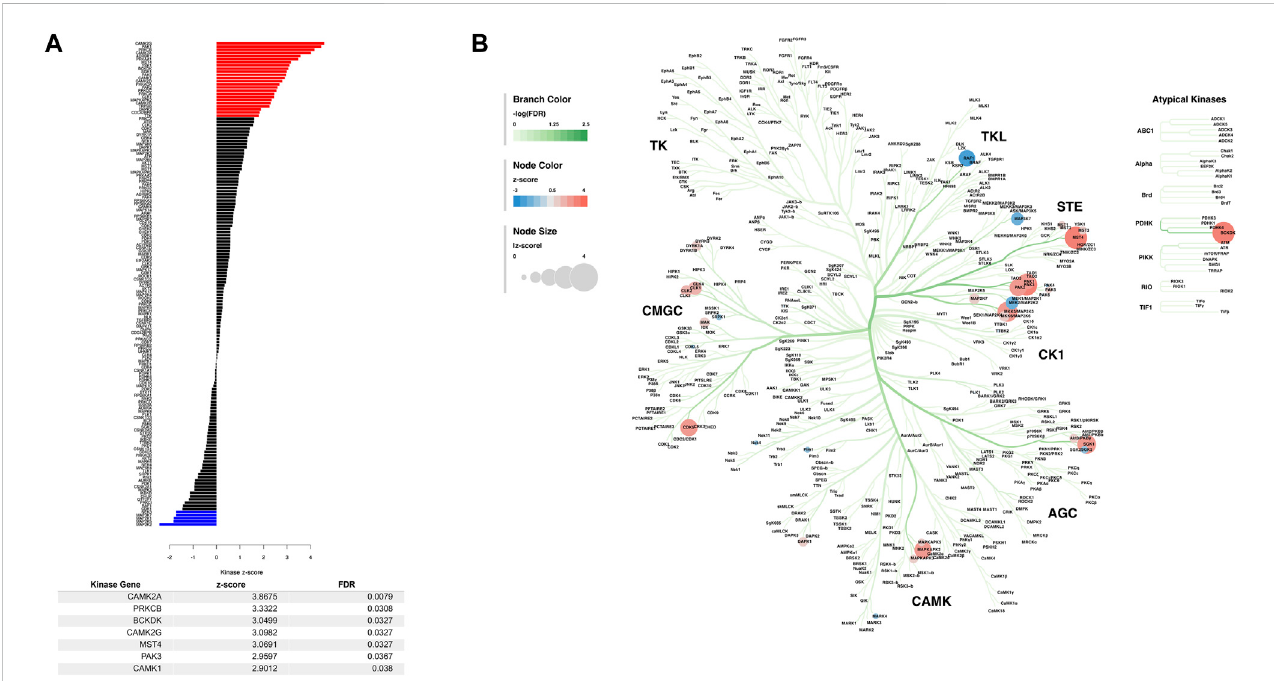
FIGURE 3 Dysregulated kinases and kinome mapping in the primary motor cortex (M1). The results of a kinase-substrate enrichment analysis (A) showing kinases that are signi fi cantly dysregulated between PME and PSE (blue bars represent decreased kinases and red bars represent increased kinases as measured by z-score) with a table listing all signi fi cantly FDR corrected kinases. The results of this kinase-substrate enrichment were mapped onto a kinome tree (B) via Coral to further visualize changes in kinases due to PME. Branch color was set to represent the range of FDR signi fi cance values, node color was set to represent the range of enrichment z-scores, and the node size was set to represent the absolute value of enrichment